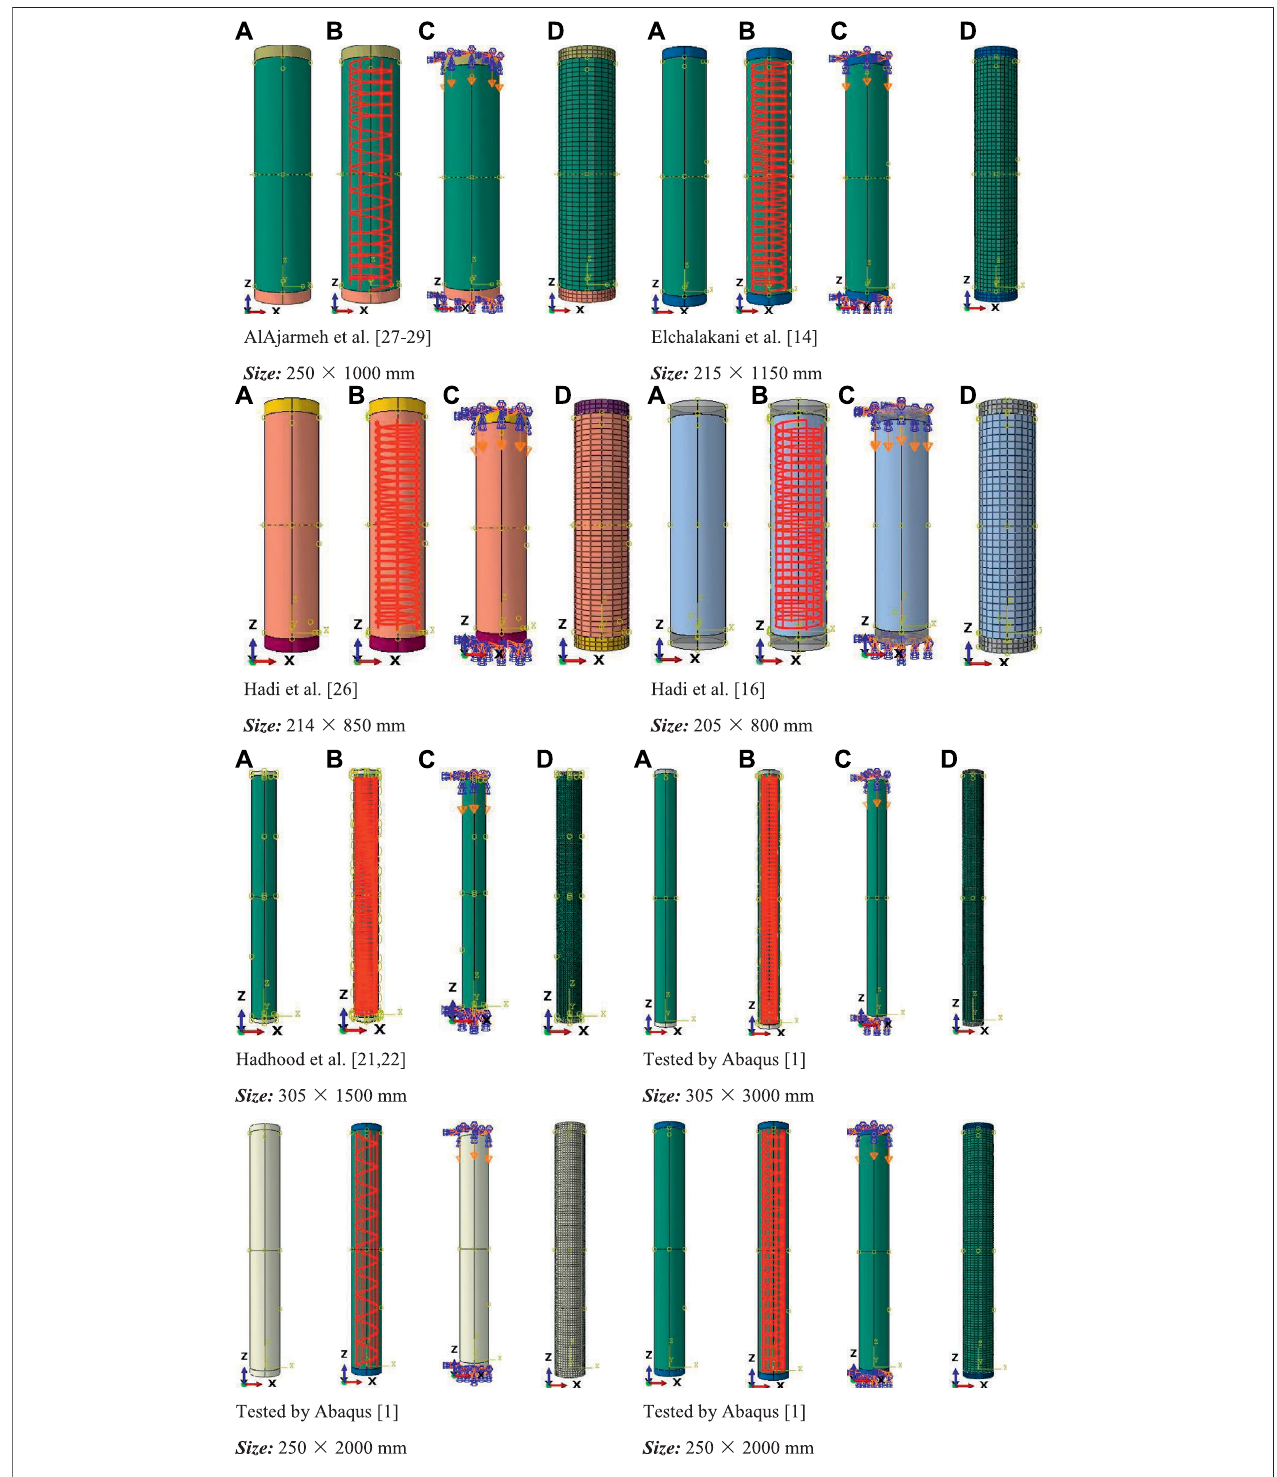
FIGURE3| FEmodelingofHCCsshowingtheassemblypart (A) ,longitudinalFRPbarsandspirals (B) ,theappliedloads (C) ,andelementmeshing (D) .Tobeable to describe relationships between the elements of the structures, a three-dimensional coordinate axis system is also provided.